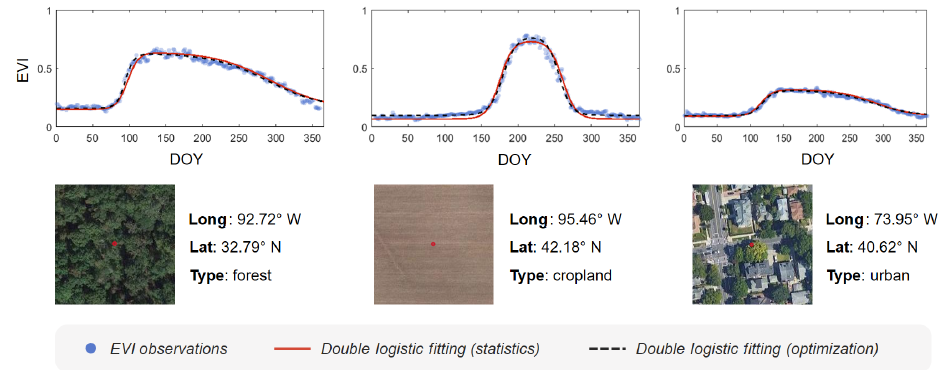
Figure 2. Seasonal patterns of vegetation growth captured by the double logistic model for three distinctly different land cover types. The extent of a snapshot is 100m × 100m, and the red dot in the snapshot is the location of the enhanced vegetation index (EVI) plot. EVI observations were composited using all clear-sky pixels during the past 3 decades (1985–2015).